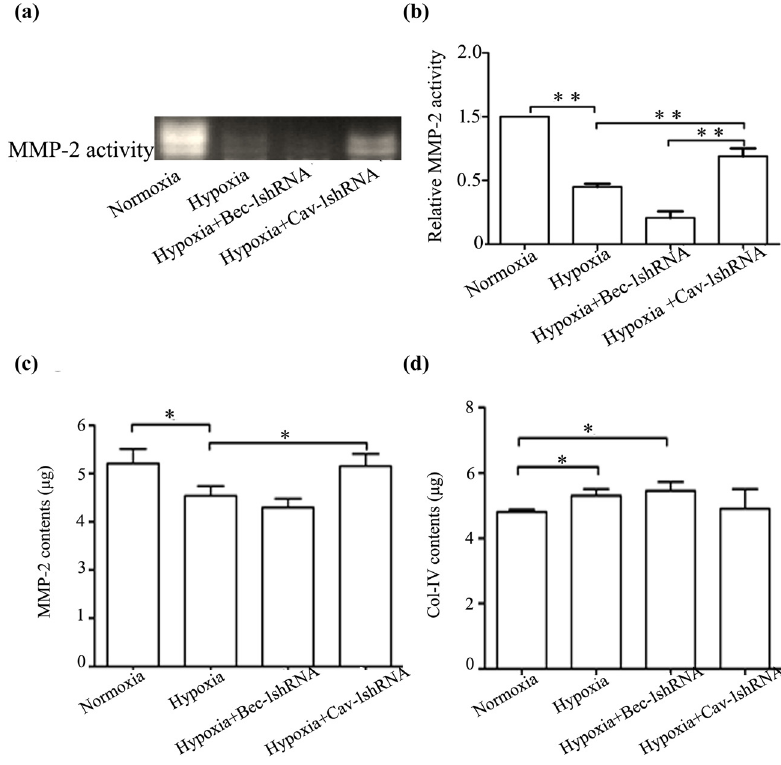
Figure 6: E ff ect on MMP - 2 activity in culture media by Bec - 1shRNA or Cav - 1shRNA. ( a ) MMP - 2 activity was evaluated by gel zymography in the culture media of hypoxia - treated HK - 2 cells. MMP - 2 activity was signi fi cantly higher in the group in which Cav - 1 was downregulated than that in the hypoxia group. ( b ) Gels were scanned and quanti fi ed by densitometry and the relative MMP - 2 activity was calculated as a percentage of the relevant control values ( assigned values: 1 ) from arbitrary densitometry units. The data are the mean of the three separative experiments. ( c ) The contents of MMP - 2 protein in cell culture supernatants were detected by ELISA. The results were similar to the change of MMP - 2 activity in culture media. ( d ) The contents of Col - IV protein in cell culture supernatants were detected by ELISA. The results were reversed for MMP - 2 protein in the culture media. Error bars represented mean ± SD, and the results were analyzed by unpaired with Student ’ s t - test, * p < 0.05, ** p <